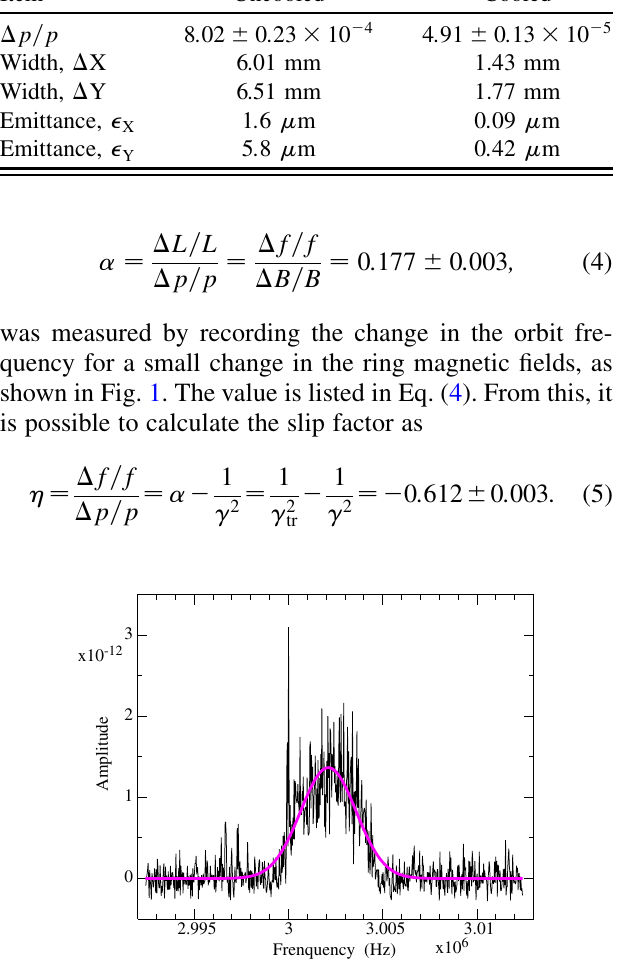
FIG. 2. Measurements of the Schottky signal on the fourth harmonic for an uncooled beam. The frequency is nominally 3 002 410 Hz. The Gaussian fit is shown by the purple curve.